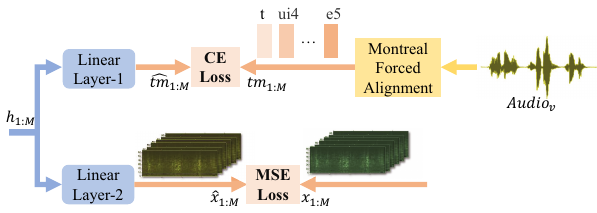
Figure 6. Detail of joint optimization. tm 1: M is the tonemes with tones from MFA while ˆ tm 1: M is the tonemes predicted after the linear layer. x 1: M is the sEMG v while ˆ x 1: M is the sEMG v reconstructed from the linear